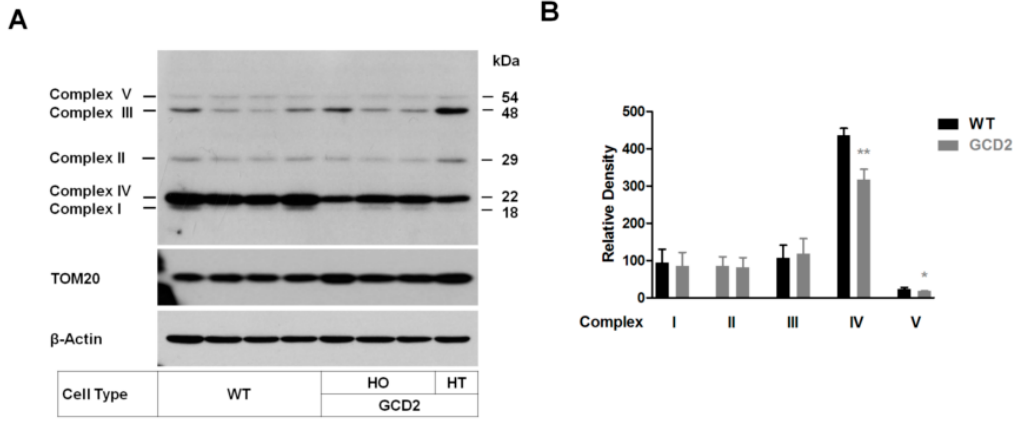
Figure 5. Levels of mitochondrial complex proteins. ( A ) Western blot analysis of the subunits of OXPHOS complexes I–V using the appropriate antibodies. Twenty-five micrograms of total cellular proteins from WT and GCD2 corneal fibroblasts were electrophoresed through SDS-PAGE gel and hybridized with an antibody cocktail specific for the subunits of each OXPHOS complex and with β -actin and TOM20 (mitochondrial membrane protein) as the loading control. A cocktail antibody comprising the following subunits of respiratory complex proteins was used: NADH dehydrogenase (ubiquinone) 1 β subcomplex 8 (NDUFB8; complex I), succinate dehydrogenase complex, subunit B, iron sulfur (SDHB/Ip; complex II), ubiquinol-cytochrome-c reductase core protein II (UQCR2; complex III), cytochrome-c oxidase subunit 2 (COXII; complex IV), and ATP synthase 5A (ATP 5A, Complex V). ( B ) Quantification of the levels of each of the abovementioned subunits were shown, respectively. The data are presented as % of proteins normalized to β‐ actin levels. Significances are shown as mean ± SD, n = 8, (* p < 0.05, ** p < 0.01).